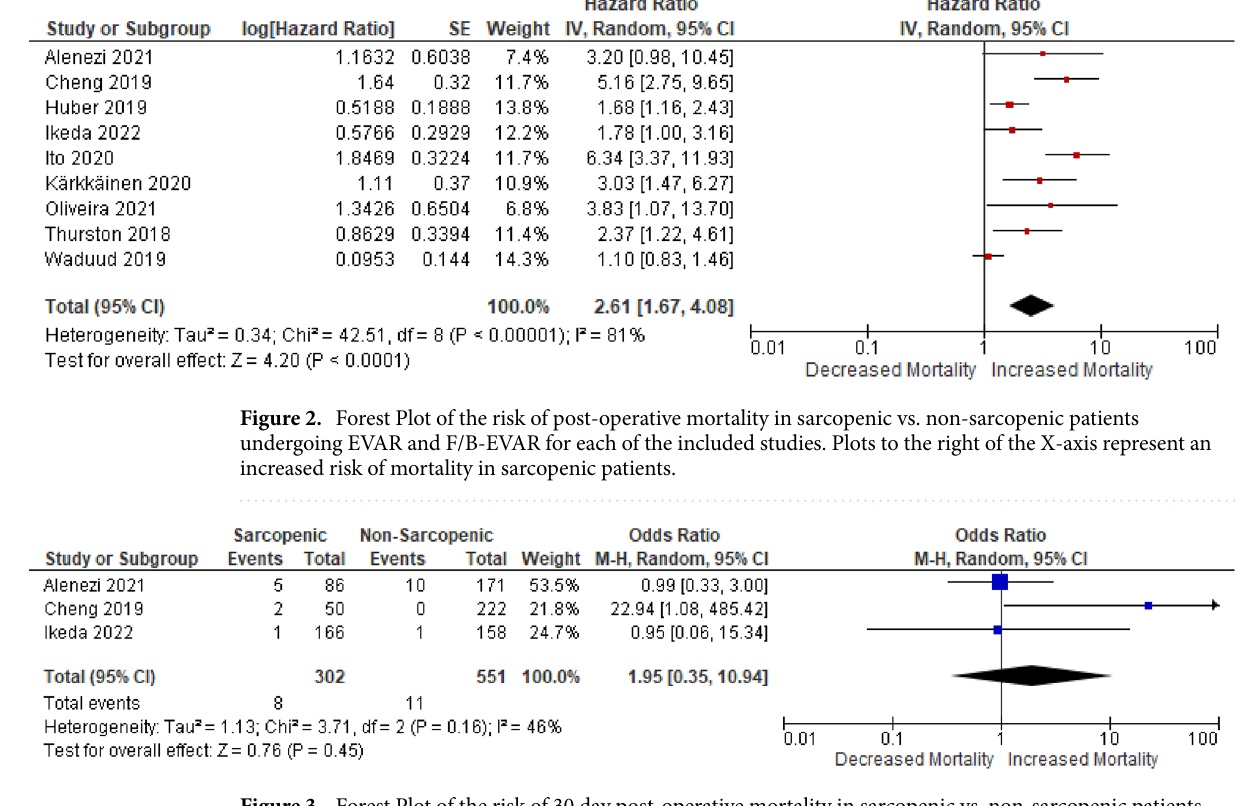
Figure 3. Forest Plot of the risk of 30 day post-operative mortality in sarcopenic vs. non-sarcopenic patients undergoing EVAR and F/B-EVAR in the included studies. Plots to the right of the X-axis represent an increased risk of mortality in sarcopenic patients.